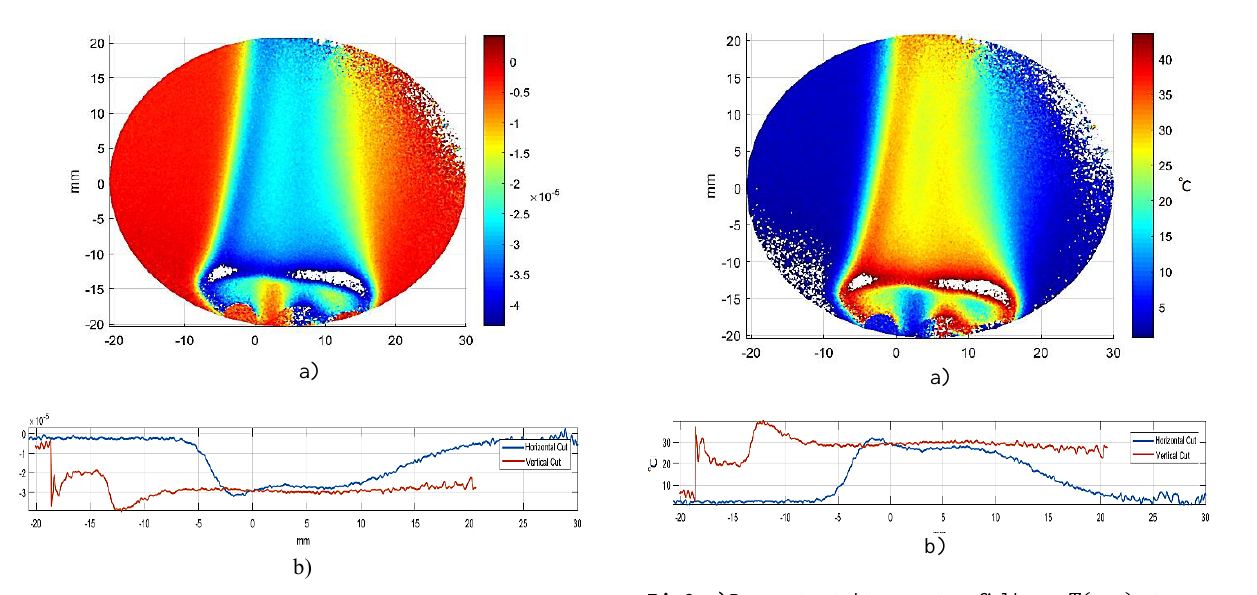
Fig.8. a) Refractive index field map at some time instant and b) refractive index profile run across the field.